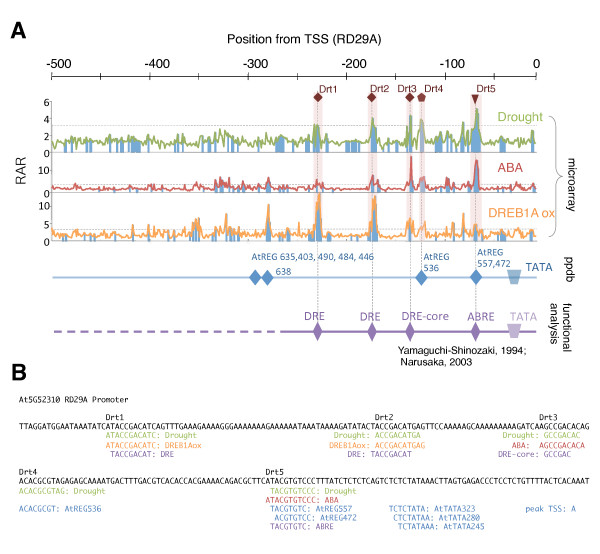
Analysis of the RD29A promoter. Panel A. The three graphs show scanning results based on microarray data of the drought response (green), the ABA response (red), and DREB1A overexpressors (orange). The regions filled with the blue bar indicate the statistically confident (P < 0.05) areas. Predicted cis-elements that are related to drought, ABA, and DREB1Aox are indicated as Drt1 to 5 (at top of the graphs). Blue line in the middle summarizes the prediction data by the ppdb, and elements in the REG in the promoter are shown. Purple line at the bottom shows cis-regulatory elements identified by functional analysis. Panel B. The sequence of RD29A promoter. Green, red and orange: predicted cis-elements from promoter scanning; blue: ppdb information; purple: functionally identified cis-elements.